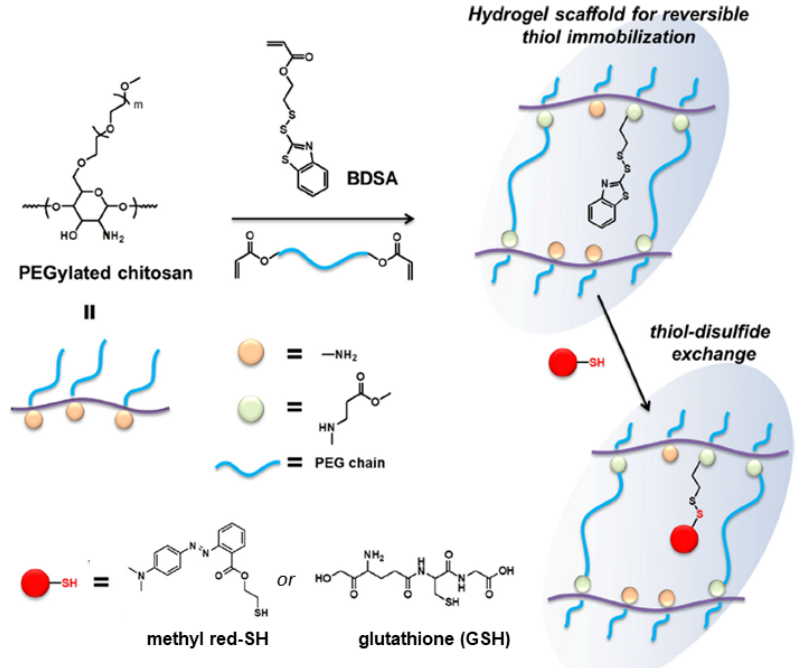
Figure 19. Conjugation of BDSA to PEG functionalized chitosan via an aza-Michael addition. A hydrogel was formed from the BDS-containing PEG functionalized chitosan, and a thiol-disulfide exchange reaction tethered the thiolated cargo molecules (red dot) to it. Adapted with permission from [87]. Copyright (2020) Elsevier B.V.